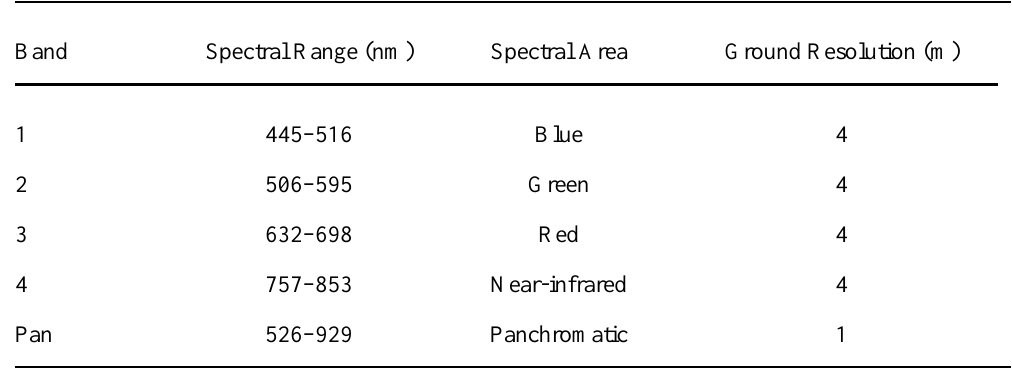
Table 1. Spectral ranges and resolutions of IKONOS bands used in the supervised